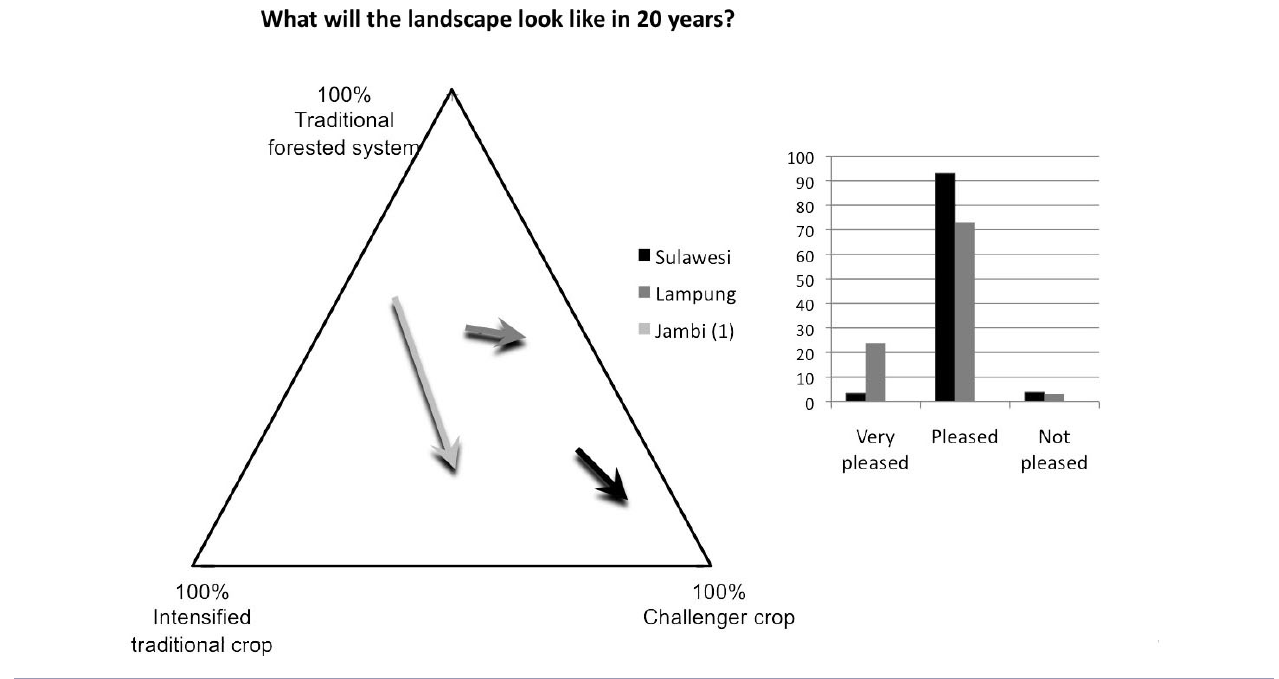
Fig. 5 . Illustration of landscape predictions for each site (responses to perception survey) (adapted from Therville 2008). Each point of the triangle represents 100% of land cover of the traditional forested system (damar agroforest in Lampung, rubber agroforest in Jambi, upland rice in Sulawesi), the intensified traditional crop (rubber monoculture in Jambi, coffee monoculture in Lampung, swidden fallows enriched in cocoa or coffee in Sulawesi), or the challenger crop (oil palm in Jambi, cocoa plus oil palm in Lampung, cocoa monoculture in Sulawesi). The arrows represent the proportions of land cover estimated by the respondents (average of all responses) at present and in 20 years from now. The bar chart illustrates the farmers’ feelings in relation to the scenario they predicted; the data are missing for Jambi (not included in Therville's